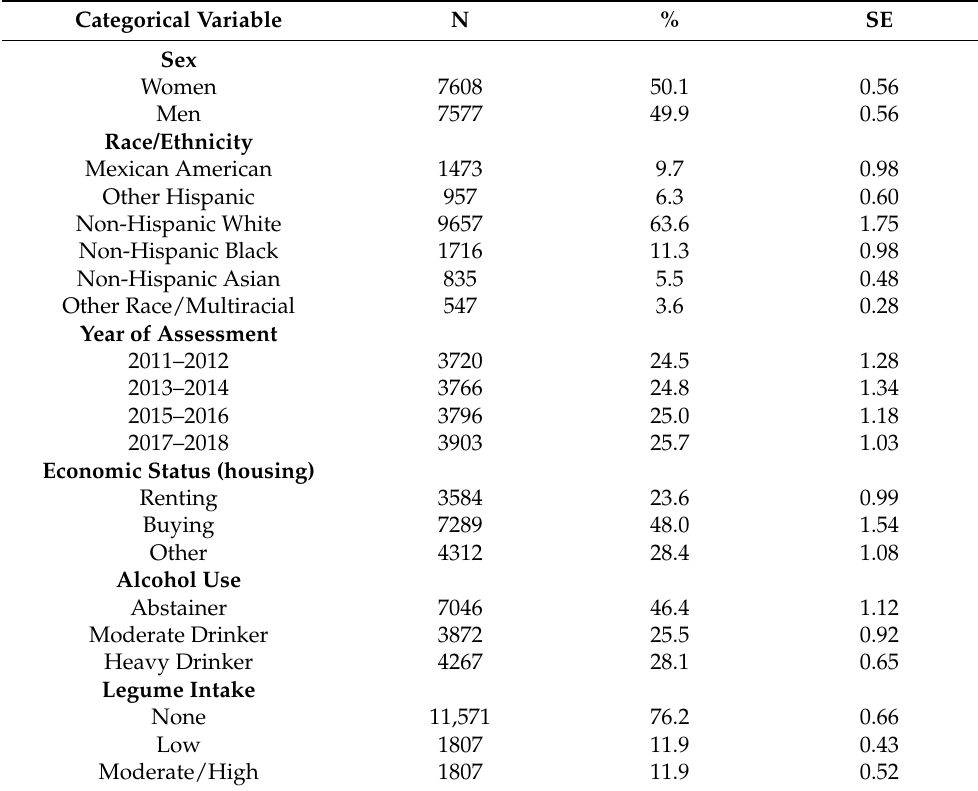
Table 2. Characteristics of the sample based on weighted values for each column for the categorical variables (n =